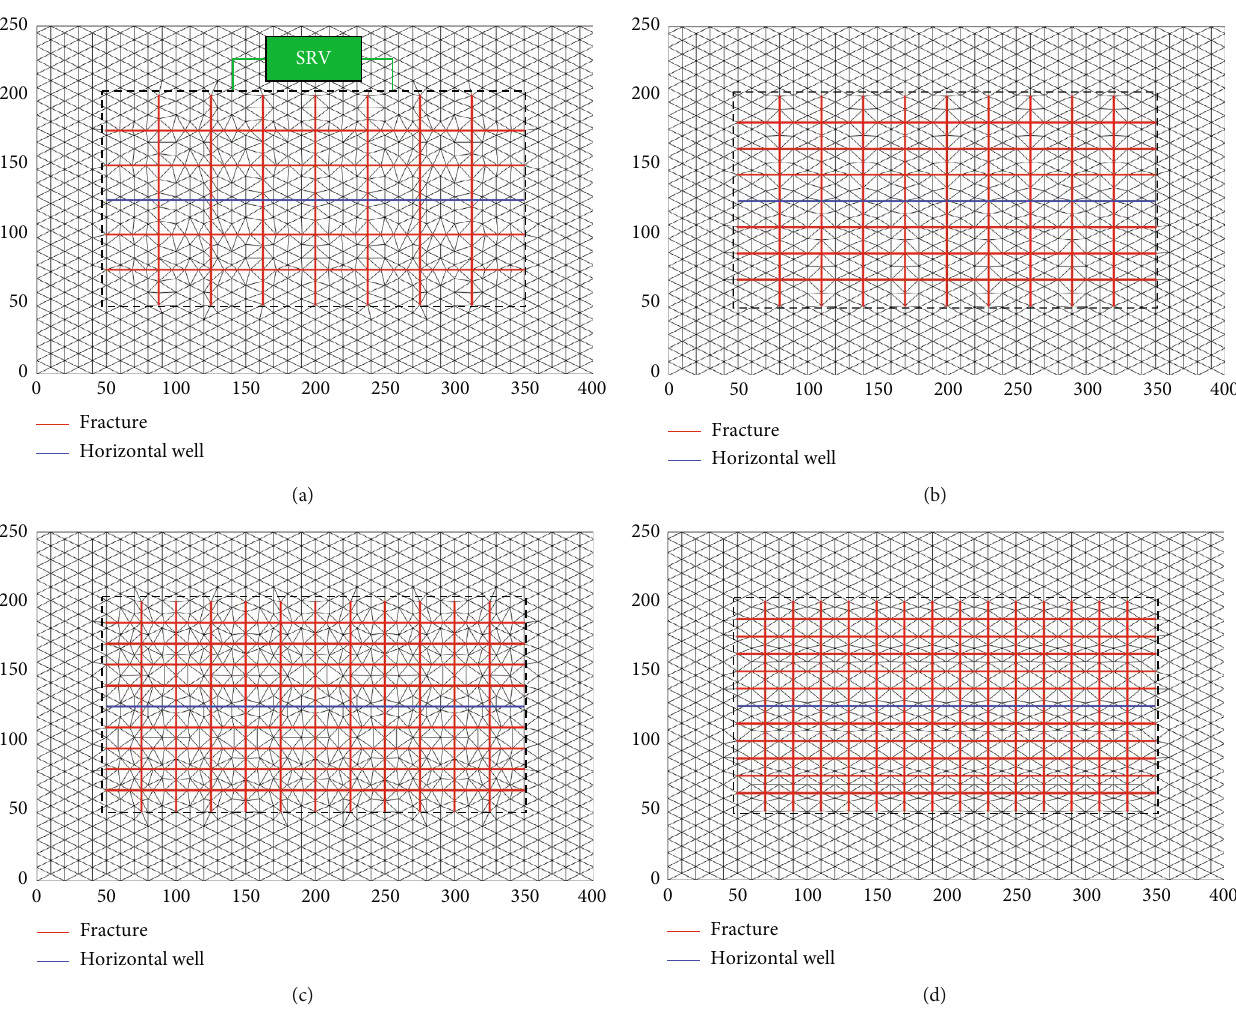
Figure 3: Grids with di ff erent fracture densities: (a) FD = 0 : 05 ; (b) FD = 0 : 07 ; (c) FD = 0 : 09 ; (d) FD = 0 : 11 . Table 1: Simulation parameters for the four models with di ff erent fracture